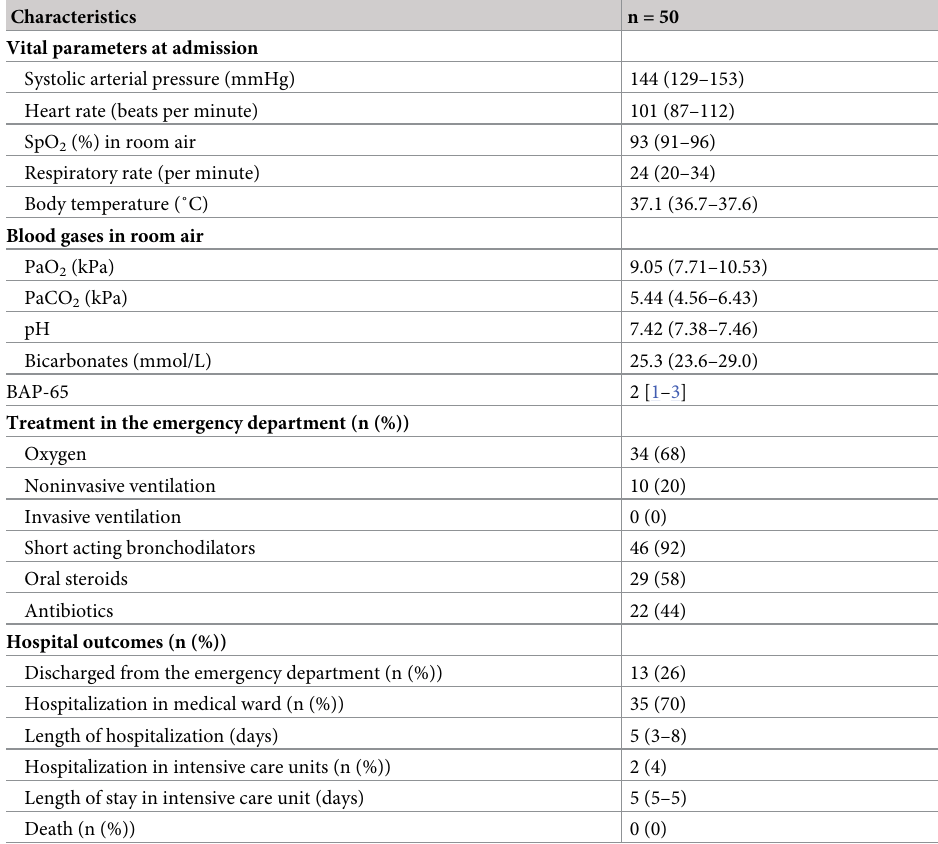
Table 2. Characteristics of